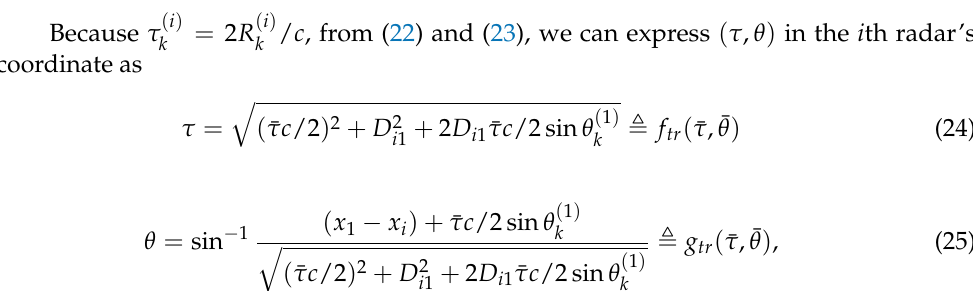
Figure 3. Coordinate transformation in distributed FMCW MIMO radar